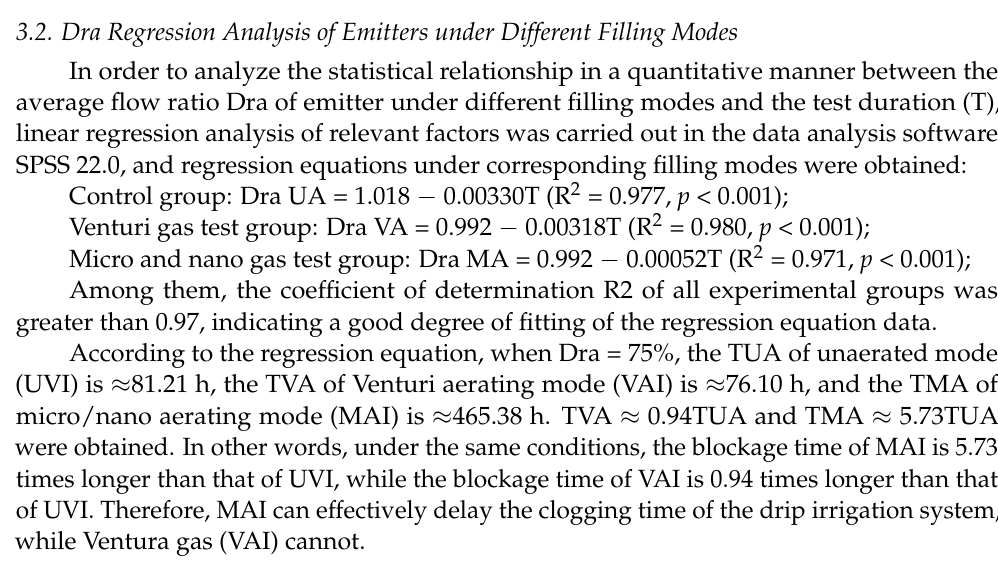
Figure 5. Distribution in the percentage of clogged emitters along the drip irrigation belt. ( a ) UAI; ( b ) VAI; ( c ) MAI.